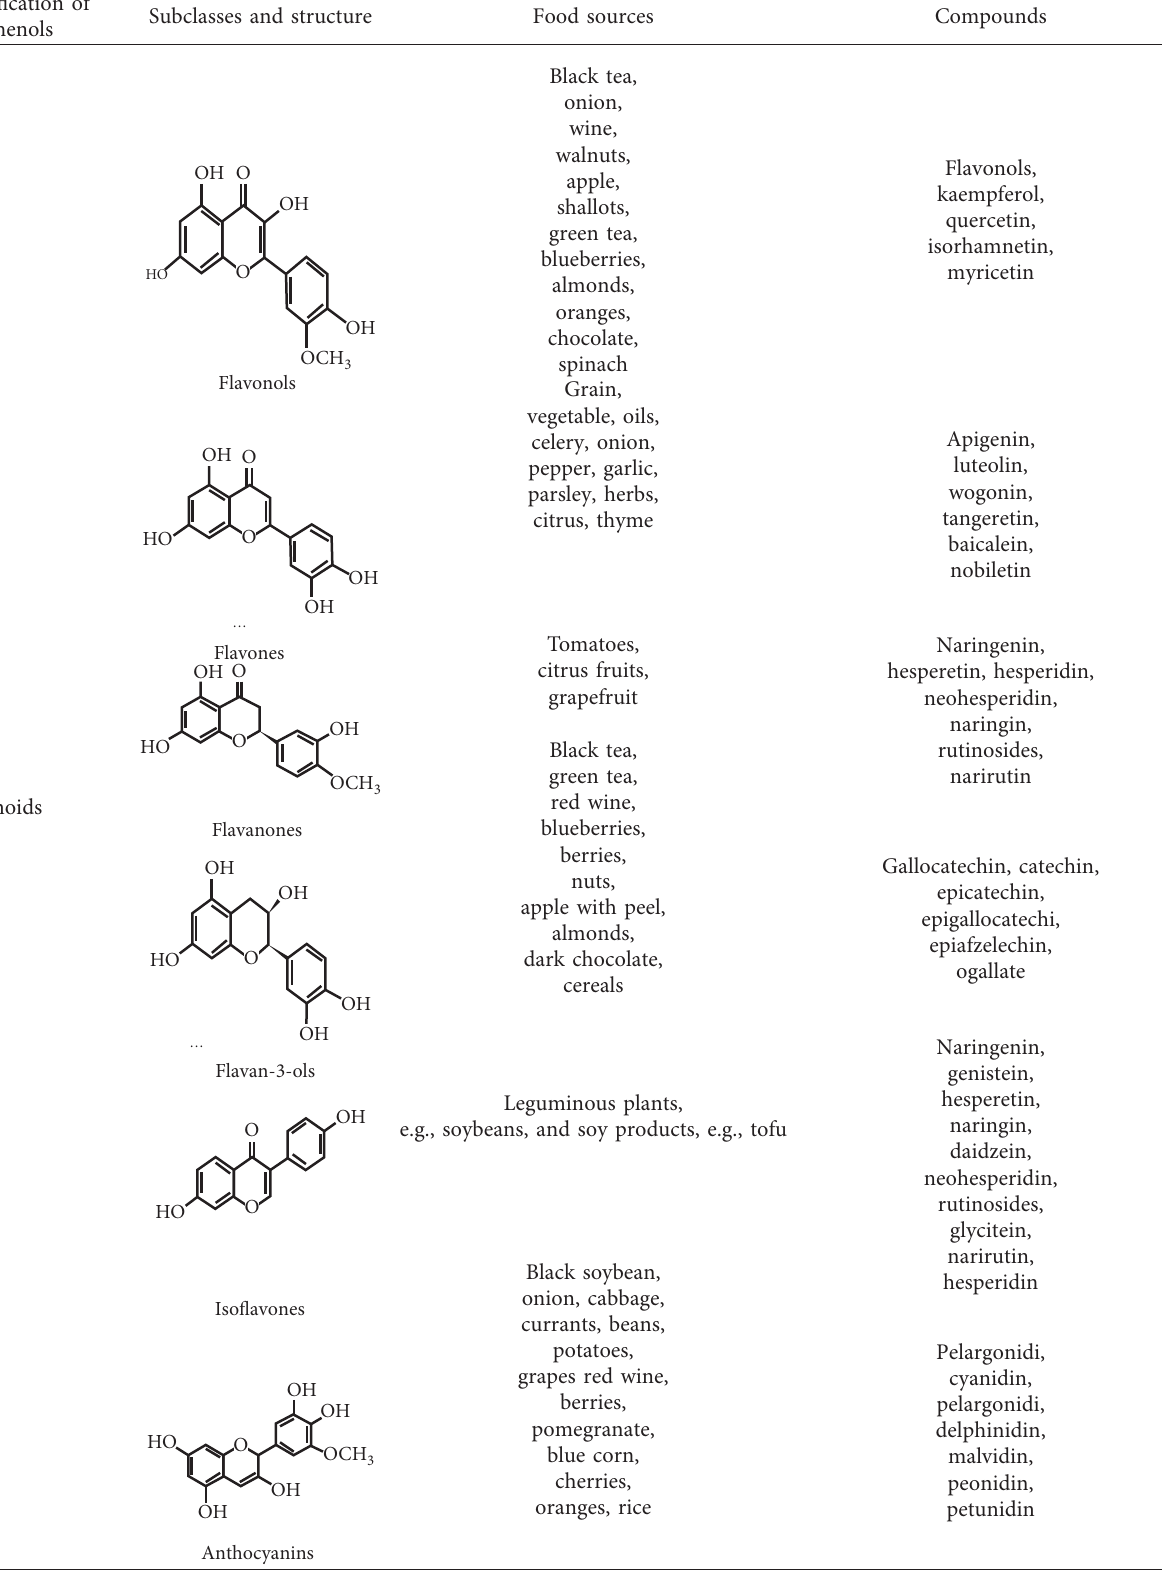
Table 1: Detailed classification of natural